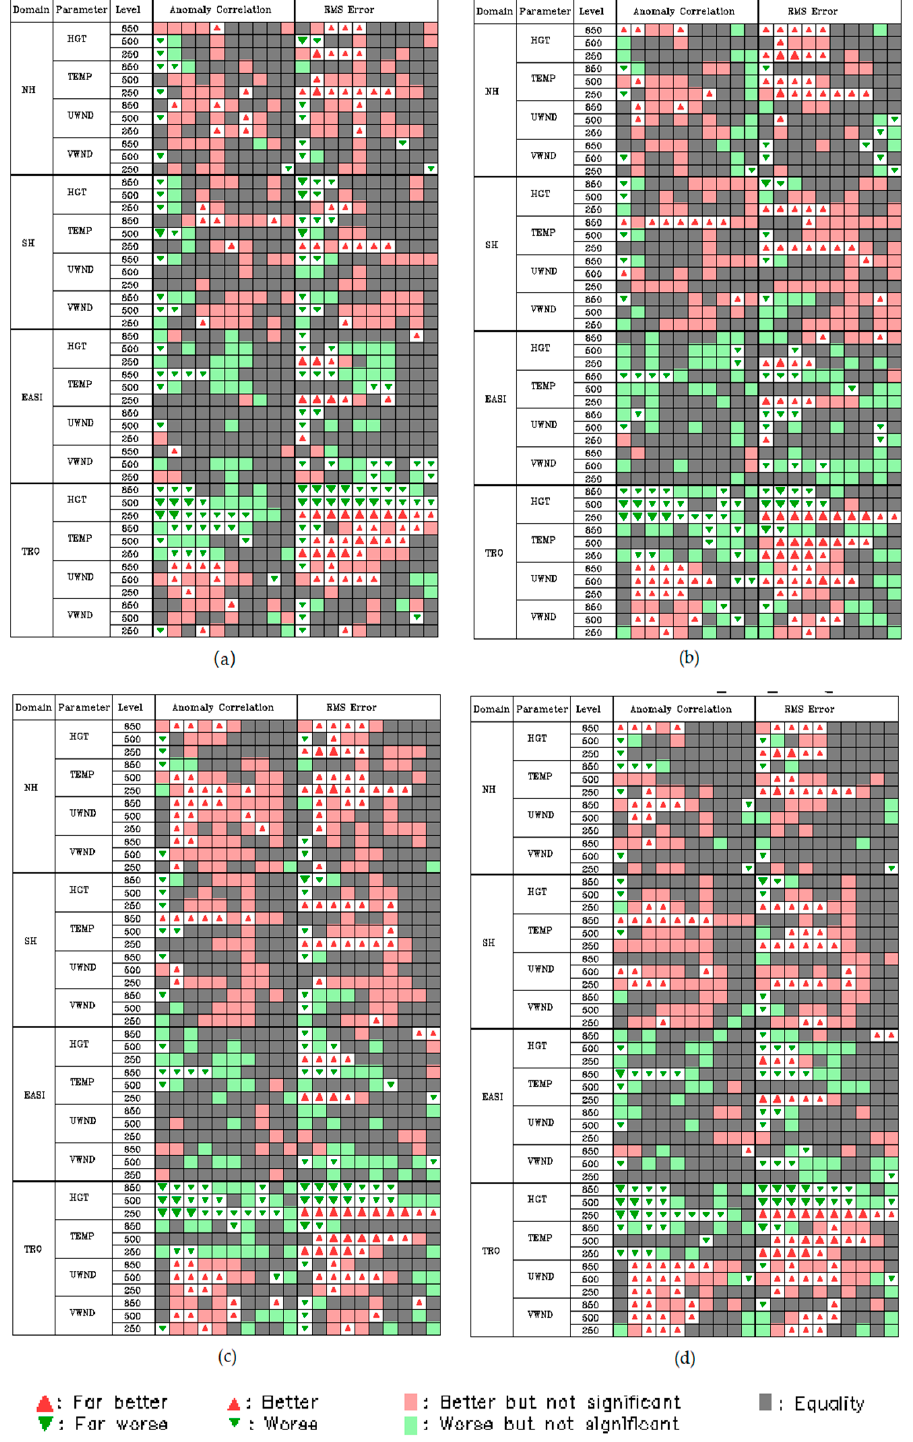
Figure 12. Change in the anomaly correction coefficient and root mean square forecast error between experiment Exp 2 ( a ), 3 ( b ), 4 ( c ) and 5 ( d ) and the baseline Exp 1 in Table 3 for key atmospheric variables (geopotential height, temperature, wind component u and v) through the change in the ACC and RMSE over different regions (northern hemisphere, southern hemisphere, Asia and the tropics) in a range of forecast lead times over the period 16 July to 15 August 2021. Upward-pointing red triangles denote improvement and downward-pointing green triangles denote degradation, respectively. Grey block shows